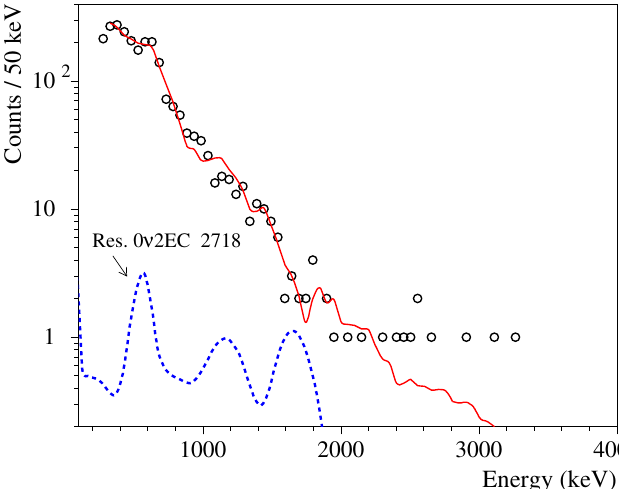
Figure 9. Energy spectrum of γ and β events measured by the 106 CdWO 4 detector for 26,033 h in coincidence with event(s) in at least one of the CdWO 4 counters in the energy interval ( 1046 − 1.5 σ ) − (1160 + 1.7 σ ) keV (circles) and its fit by the model of background (red line). The excluded distribution of a possible resonant 0 ν 2EC decay of 106 Cd to the 2718 keV excited level of 106 Pd with the half-life T 1/2 = 2.9 × 10 21 yr is